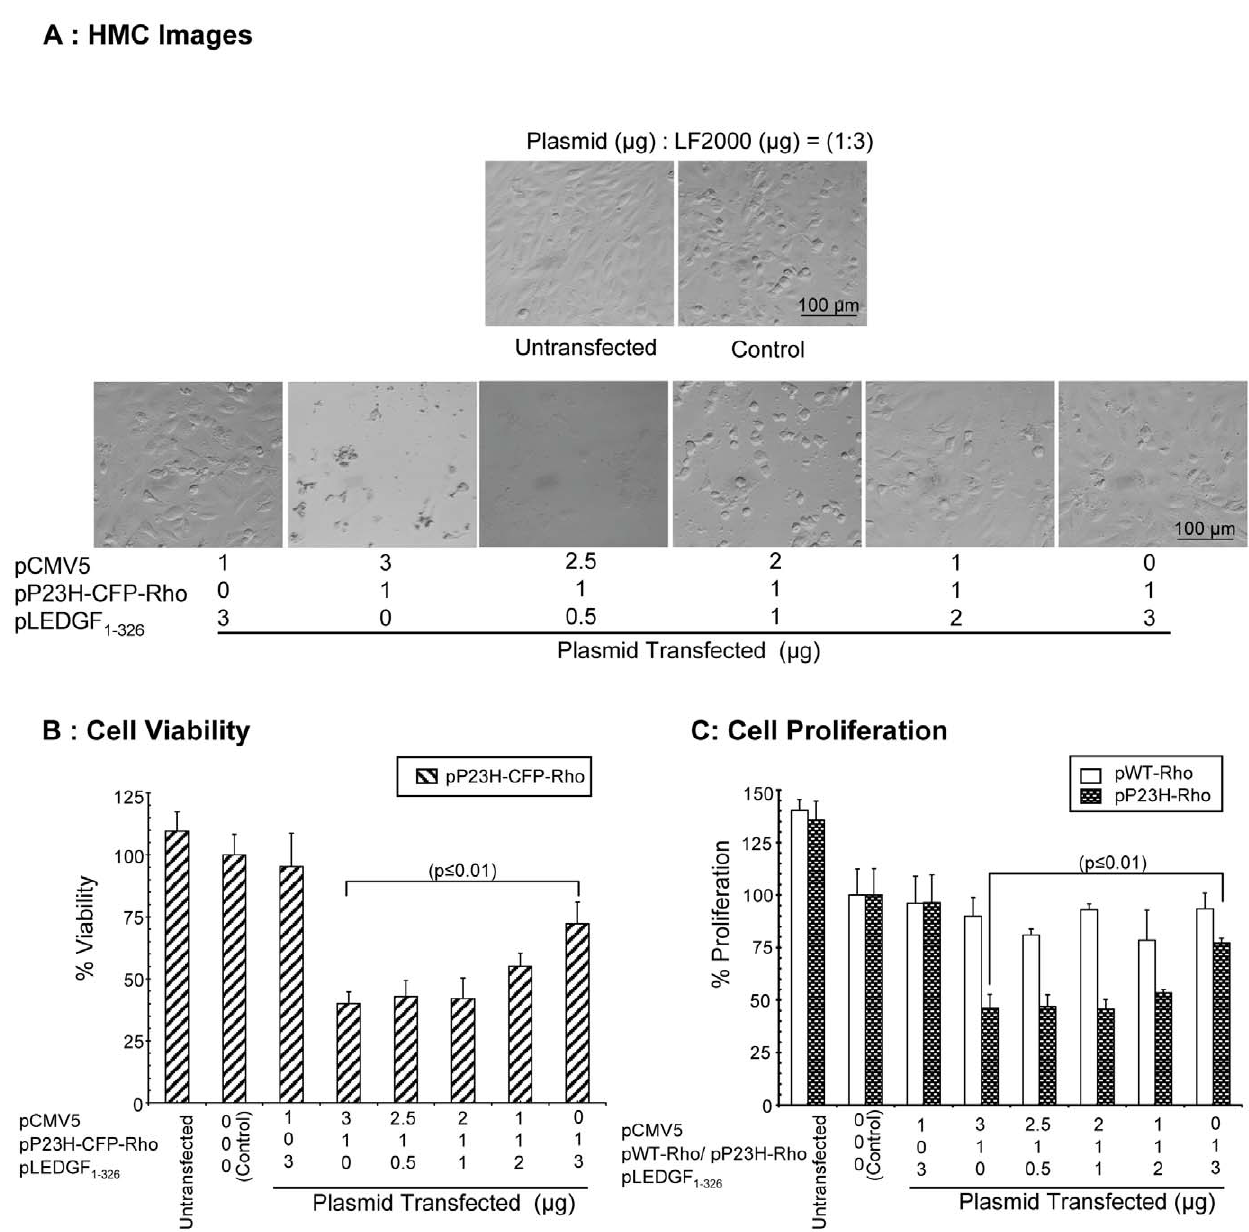
Figure 3. LEDGF 1-326 increases the cell viability and proliferation in a dose-dependent manner in RPE cells expressing P23H rhodopsin. A ) For HMC images, cells were visualized using Nikon inverted light microscope at 10x magnification. Representative images from one of the three independent studies have been shown. B ) For cell viability, cells were trypsinized, collected and resuspended in PBS. Total number of viable cells was determined in each group using trypan blue assay and percent viability was calculated with respect to the group transfected with